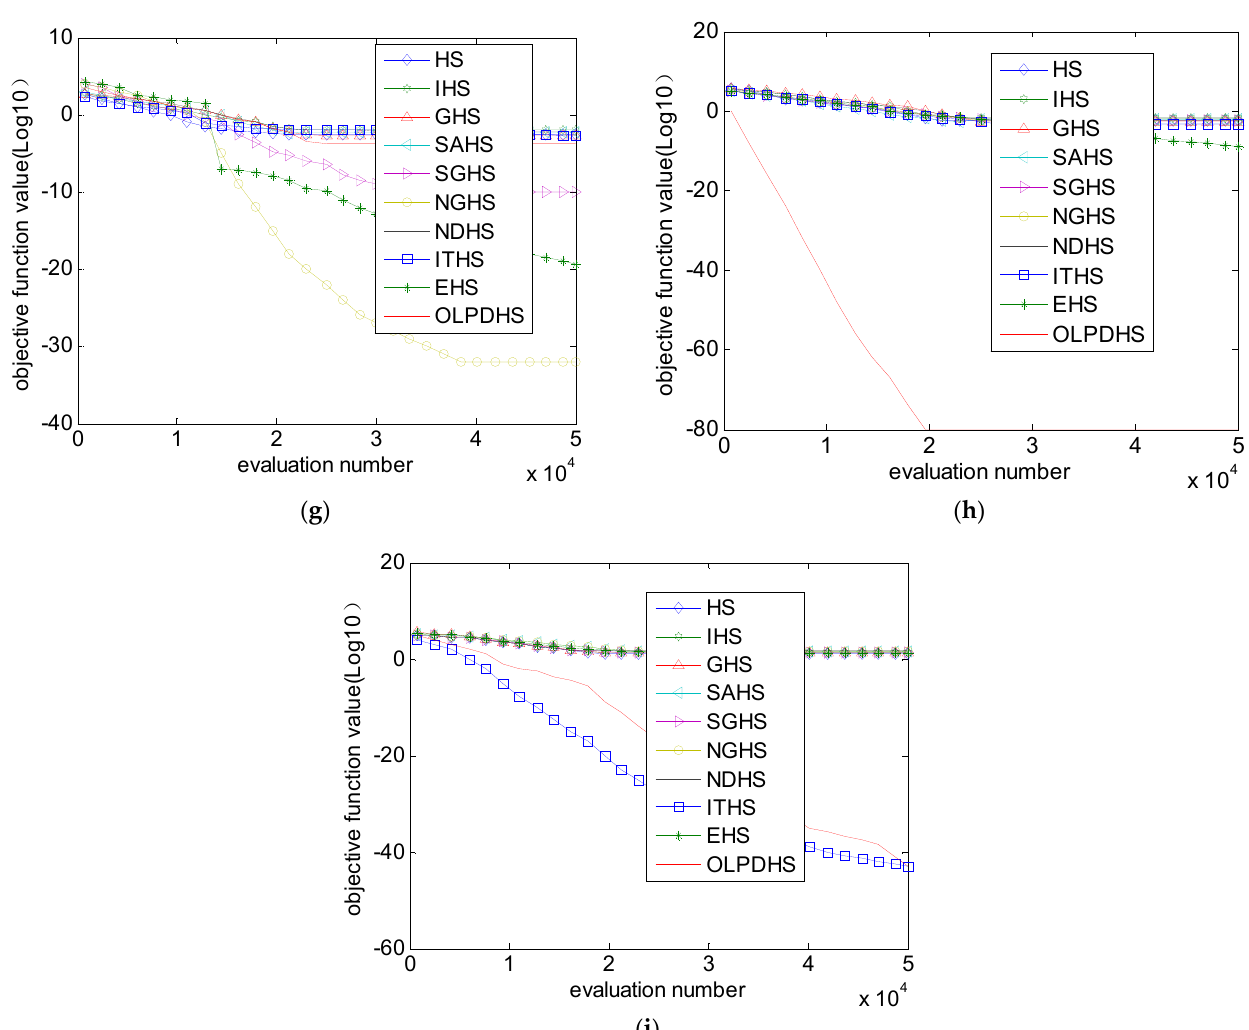
Figure 6. The evolution of optimum objective function value with 10 algorithms for 9 functions: ( a ) f 1 ; ( b ) f 2 ; ( c ) f 3 ; ( d ) f 4 ; ( e ) f 5 ; ( f ) f 6 ; ( g ) f 7 ; ( h ) f 8 ; ( i ) f 9